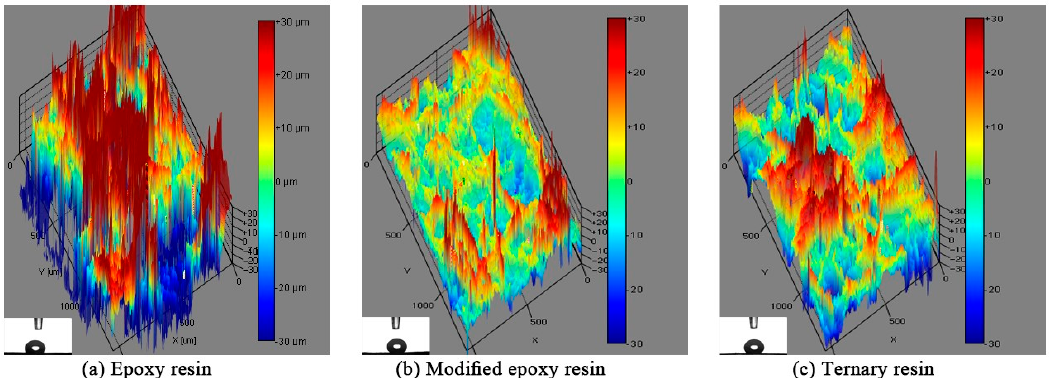
Figure 6. Surface morphology of paper-based composites impregnated with different resins: ( a ) Epoxy resin, ( b ) Modified epoxy resin, ( c ) Ternary resin.